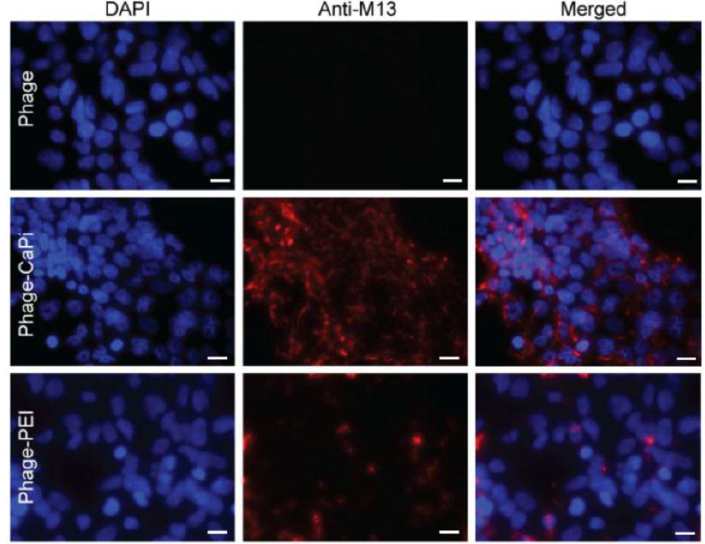
Figure 5. Phage-CaPi and phage-PEI complexes showed enhanced cell surface localization. HEK293 cells were treated with optimized ratios of phage premixed with either CaPi or PEI. Co-localization of complexes with cells was analyzed by using confocal microscopic imaging. Phage vector particles were double immunofluorescence stained with a rabbit anti-M13 phage primary antibody followed by staining with goat anti-rabbit AlexaFluor-594 secondary antibody (red). Nuclei were stained with DAPI (blue). Scale bar = 10 µm.